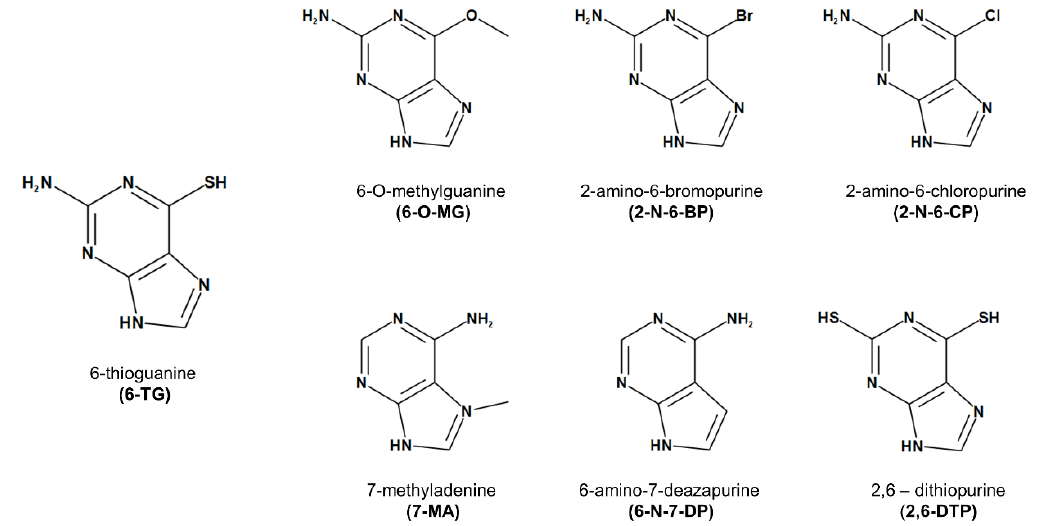
Figure 1. Chemical structure of 6-thioguanine and its analogues.